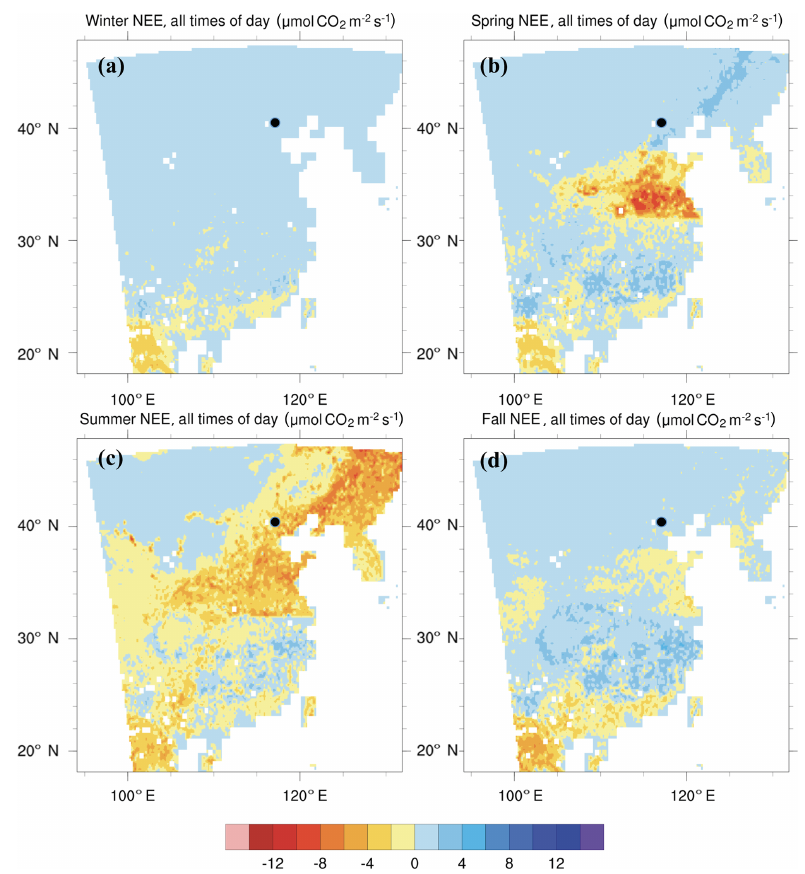
Figure 3. Mean NEE (µmolCO 2 m − 2 s − 1 ) averaged over all hours of the day from 2005 to 2009: (a) DJF (winter), (b) MAM (spring), (c) JJA (summer) and (d) SON (fall). The solid black circle represents the location of the Miyun measurement